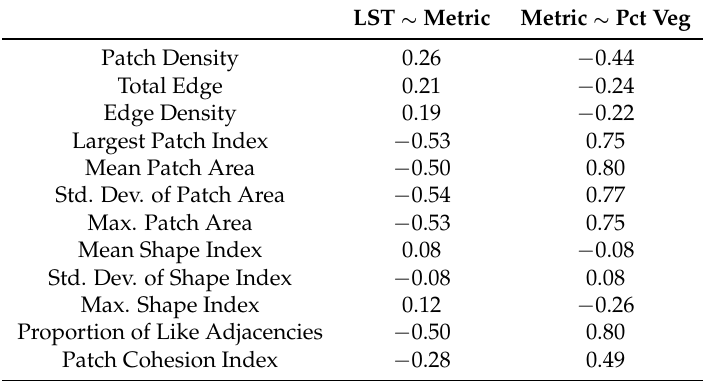
Table 5. Pearson’s correlation coefficients for LST regressed on metric values and for metrics regressed on the percent of vegetation. All metrics were significantly correlated with LST but also with the percent of